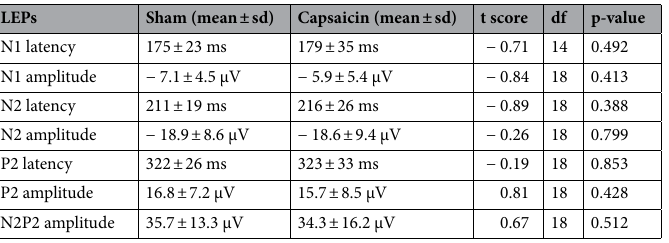
Table 4. LEPS sham and capsaicin comparison. LEPs: laser evoked potentials; df: degree of freedom; sd: standard deviation.